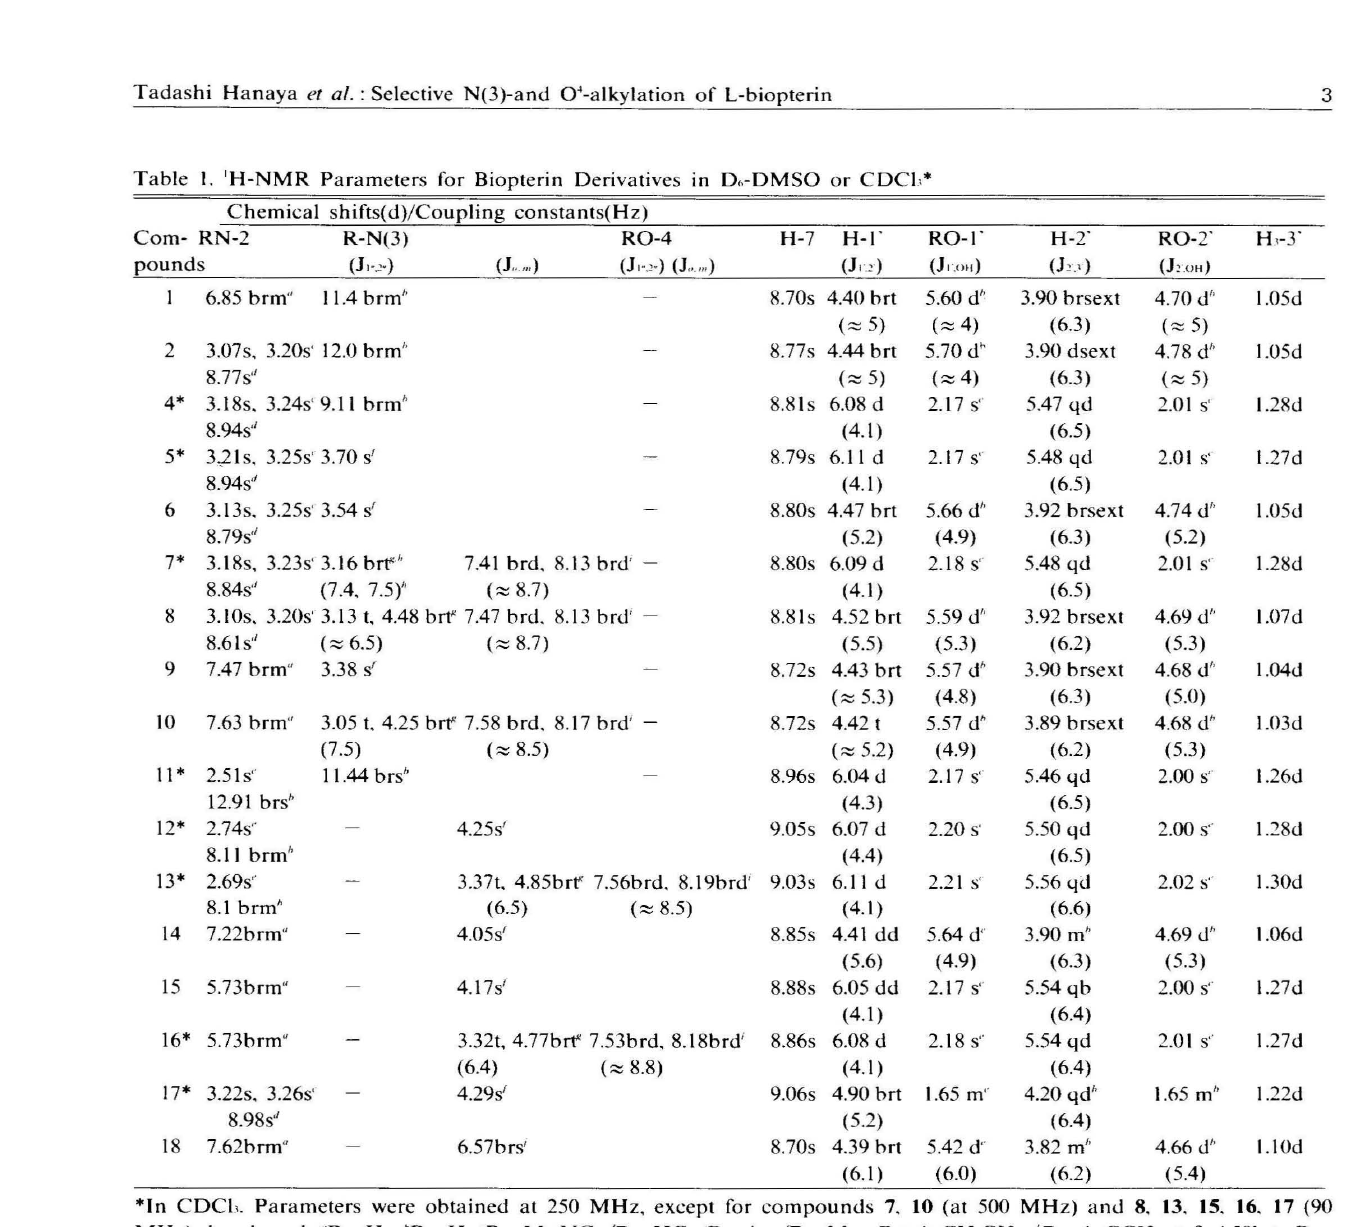
Table 1. 'H-NMR Parameters for Biopterin Derivatives in D,,-DMSO or CDC!'* Chemical shifts(d)/Coupling